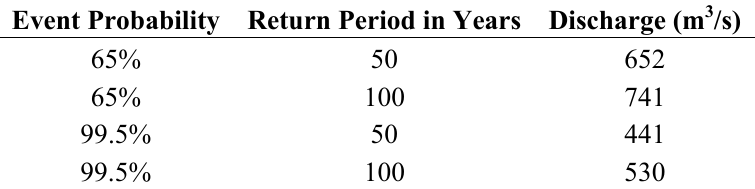
Table 2. Return periods with 65% and 99.5% probability of the 50 and 100 year discharge